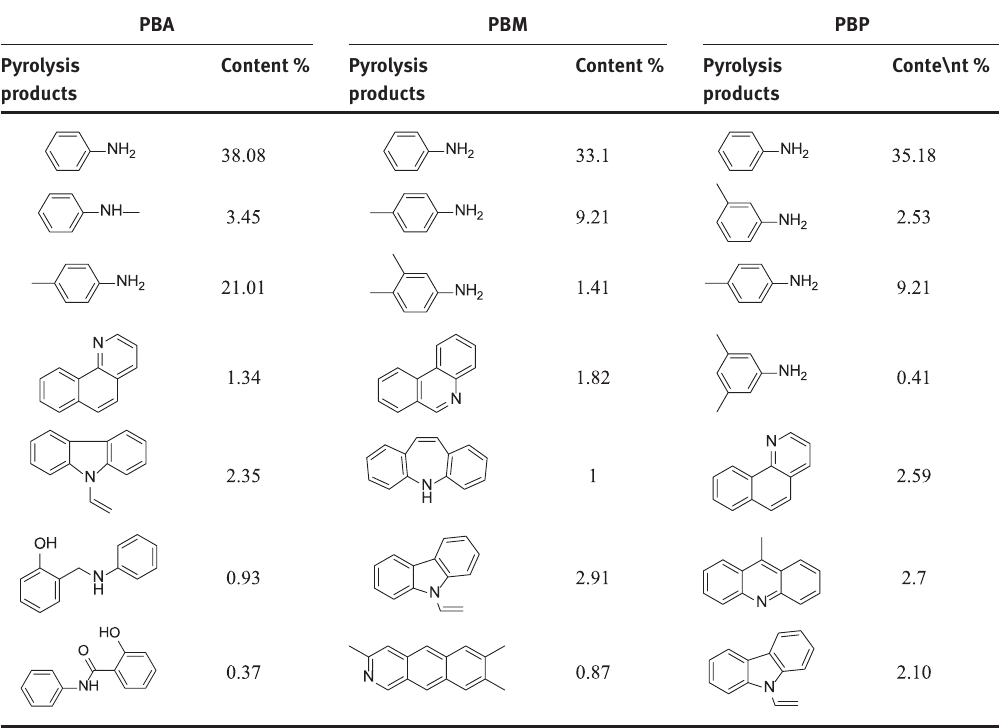
Table 1: Nitrogen-containing pyrolysis of polybenzoxazines at 650